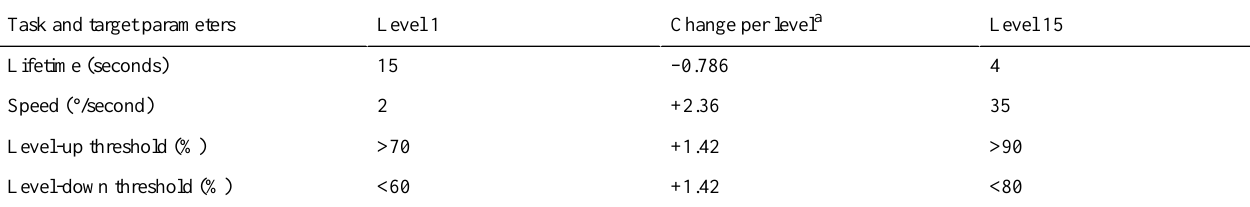
Table 1. Change per level